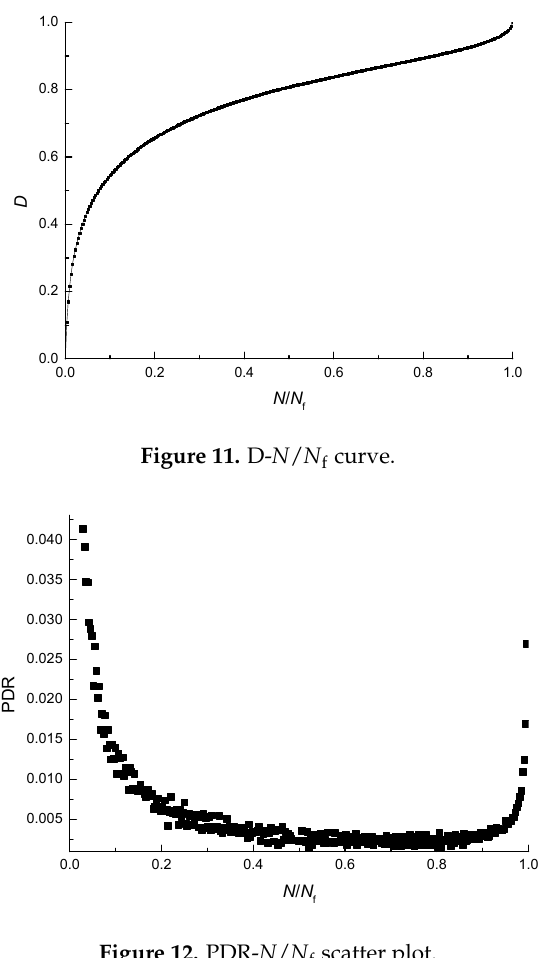
Figure 12. PDR- N / N f scatter plot.